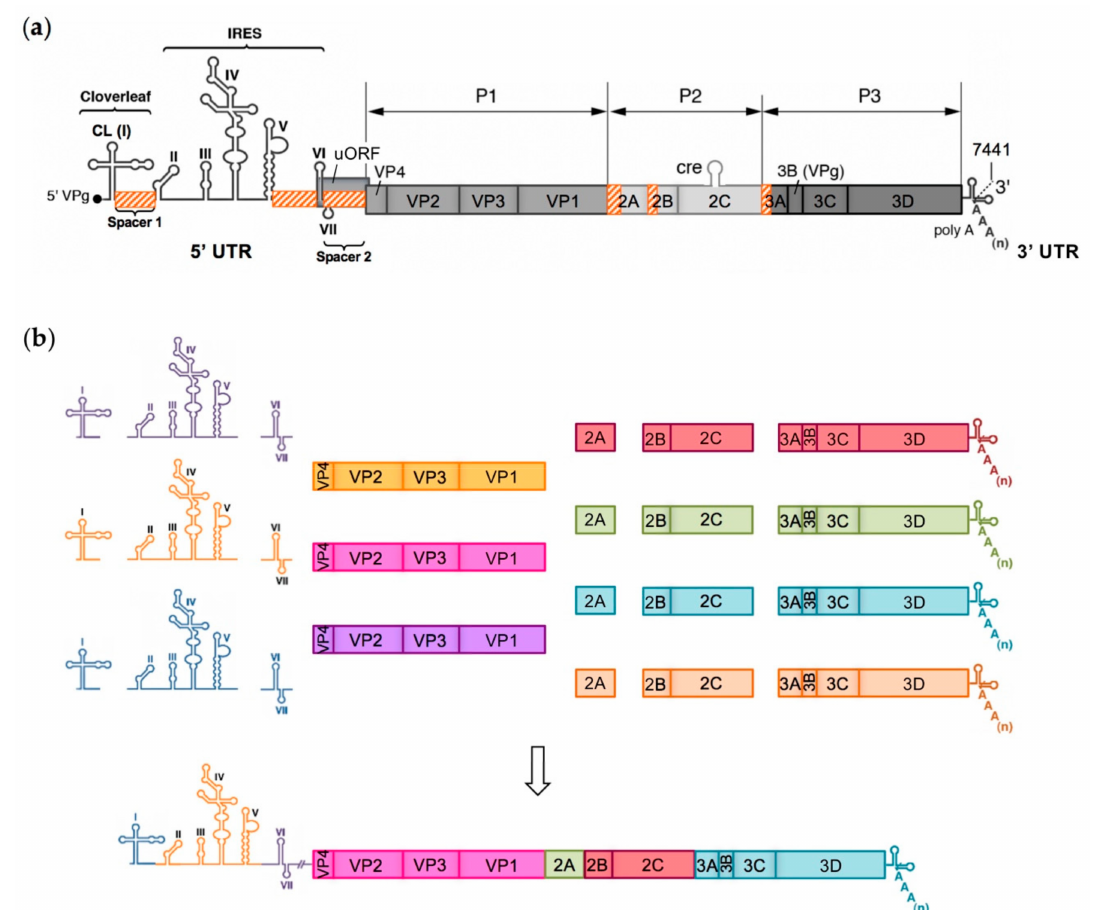
Figure 7. Model of modular evolution of species C enteroviruses. ( a ) Schematic representation of the enterovirus genomic RNA molecule. Experimental studies of genetic exchanges between poliovirus and enteroviruses led to the identification of six putative intertypic recombination hotspots, indicated by hatched orange rectangles [77,121,122]. ( b ) Modular recombination process. Each enterovirus species would exist as a pool of genetic material containing a finite set of P1 regions defining di ff erent types and a swarm of nonstructural and untranslated regions, divided in functional recombination modules and evolving independently. Each new enterovirus lineage can be considered as a new association of compatible recombination